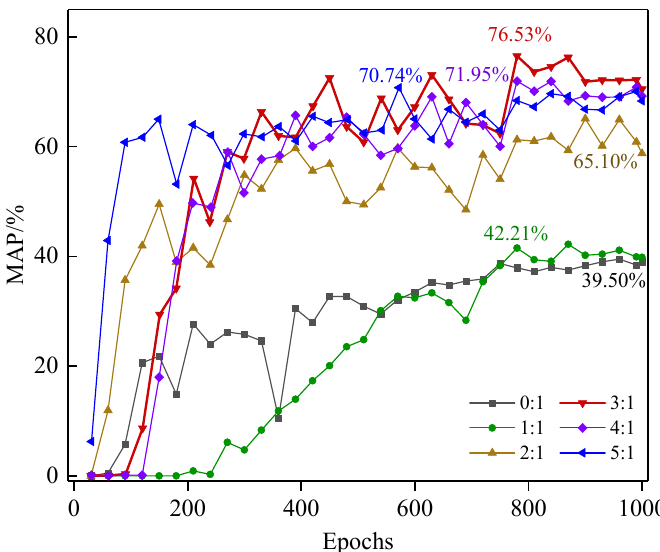
Figure 11. MAP for the integrated dataset of six virtual-to-real ratios. Table 4. Comparison of two data augmentation methods.